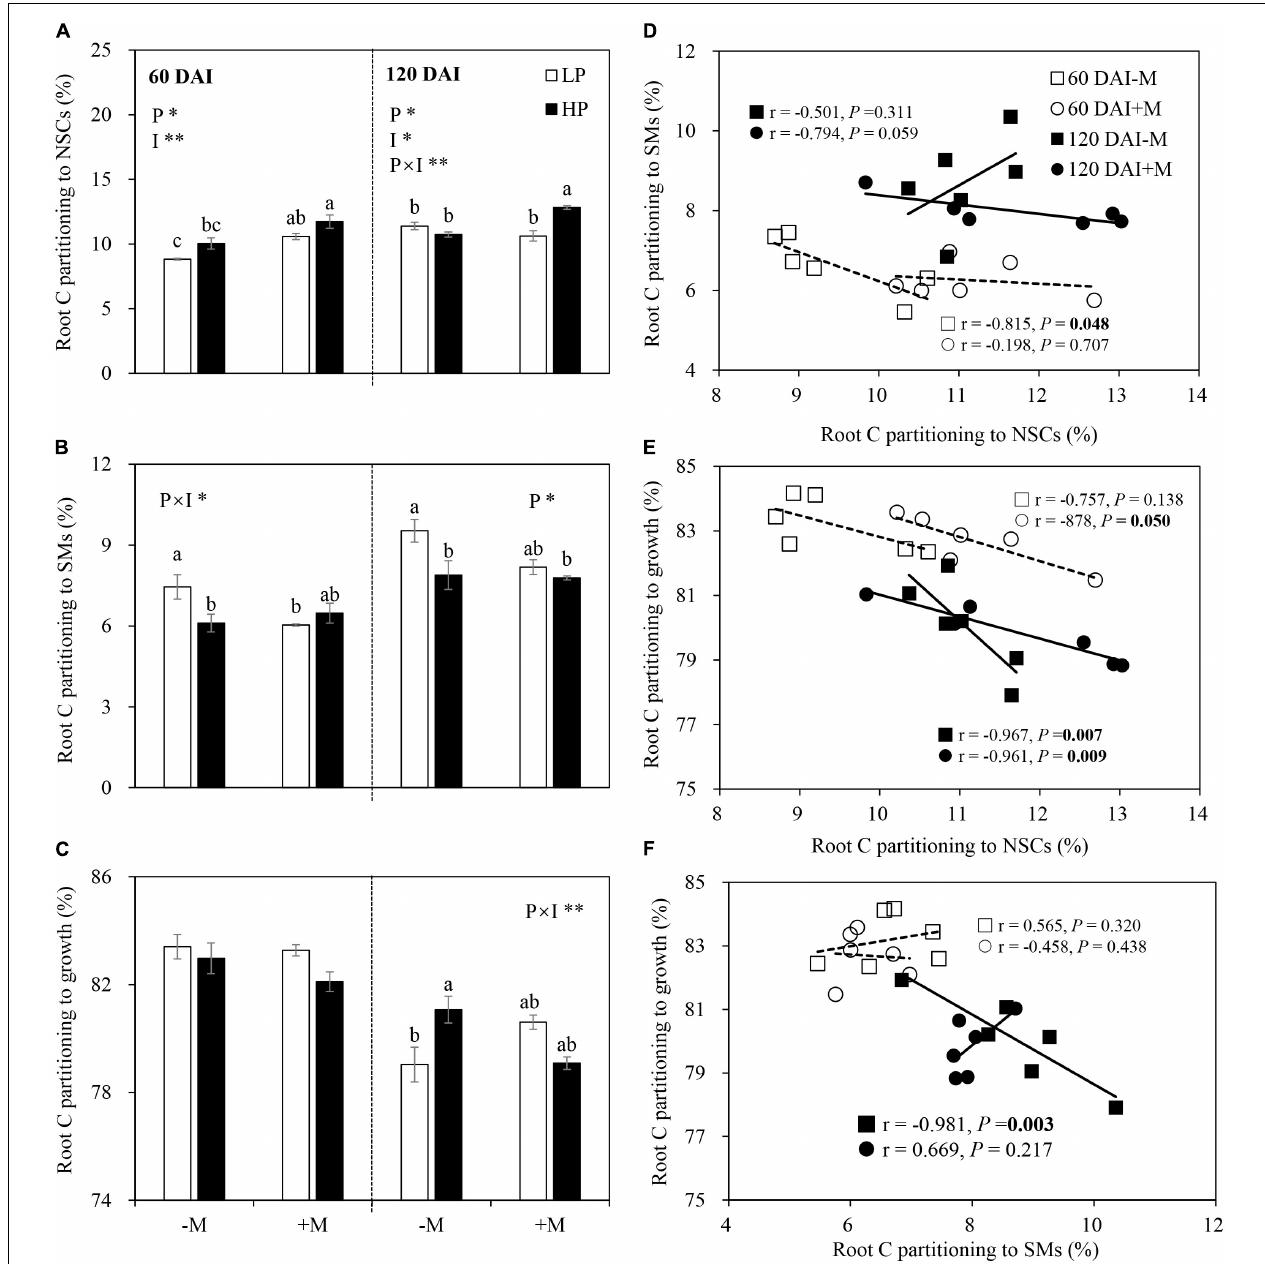
FIGURE 5 | Percentage proportion of root C partitioning to (A) NSCs, (B) secondary metabolites (SMs), and (C) root growth as affected by soil P levels (P) and mycorrhizal status (I) 60 and 120 days after inoculation (DAI). –M and +M represent non-AM and AM inoculation with R. irregularis , respectively. LP and HP represent 30 and 170 mg kg − 1 P application, respectively. Data are presented as mean ± standard error (SE, n = 3). Treatment effects were tested by two-way ANOVA separately between the two harvests. Only significant effects by ANOVA are displayed. ∗ P < 0.05; ∗∗ P < 0.01. Multi-comparison was performed across all treatments at the same harvest time, and the same letter indicates no significant difference between the means at P < 0.05 by Turkey’s HSD test. Root C partitioning to NSCs in relation to C partitioning to SMs (D) , root growth (E) , and root C partitioning to growth in relation to C partitioning to SMs (F) for –M and +M plants at two harvests separately. Pearson correlation analyses or partial correlation analyses were conducted to check the